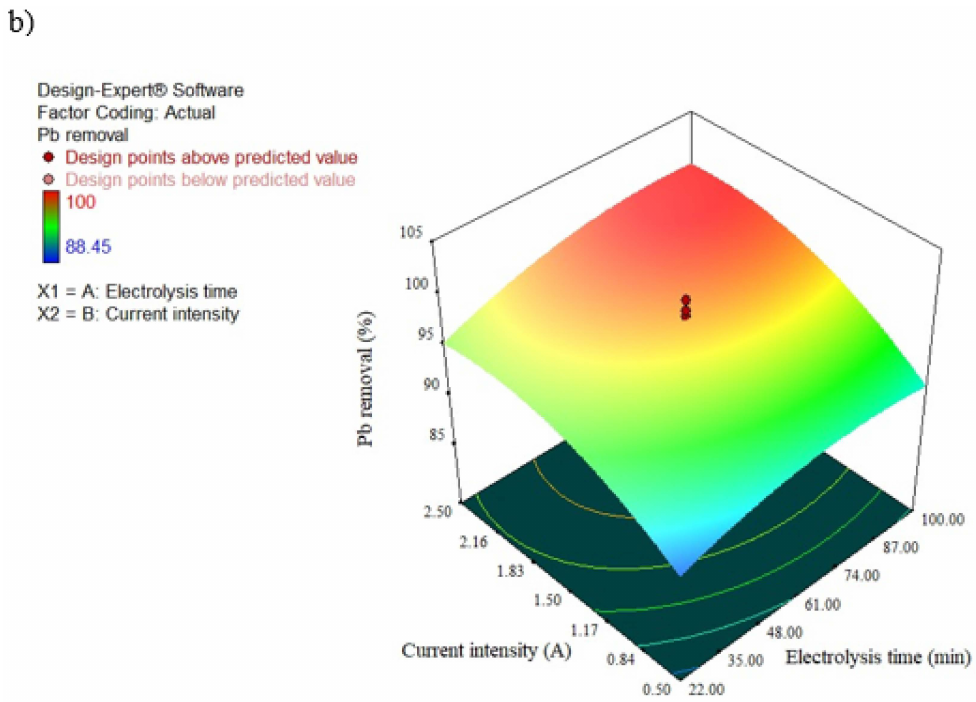
Figure 4. Contour plot ( a ), and 3D response surface plot ( b ) of the effect of current intensity and electrolysis time on removal efficiency of